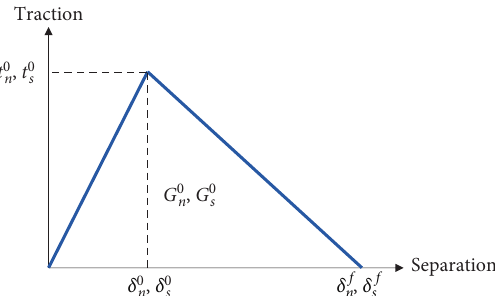
Figure 9: Illustration of a bilinear traction-separation law implemented into the CZM.